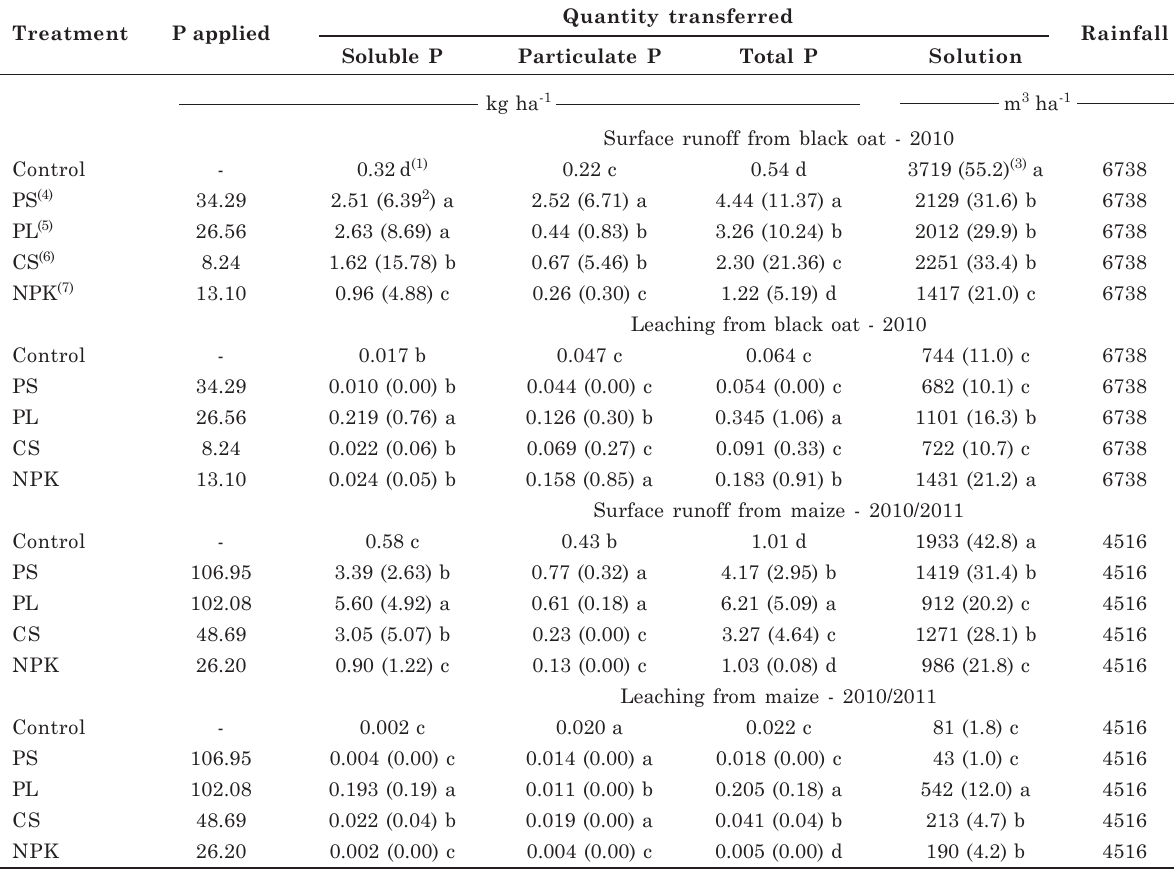
Table 3. Total quantity of phosphorus applied, total rainfall and transfer of solution via runoff and leaching and transfer of soluble phosphorus, particulate phosphorus and total phosphorus in surface runoff and leaching from black oat and maize, in a Typic Hapludalf treated with